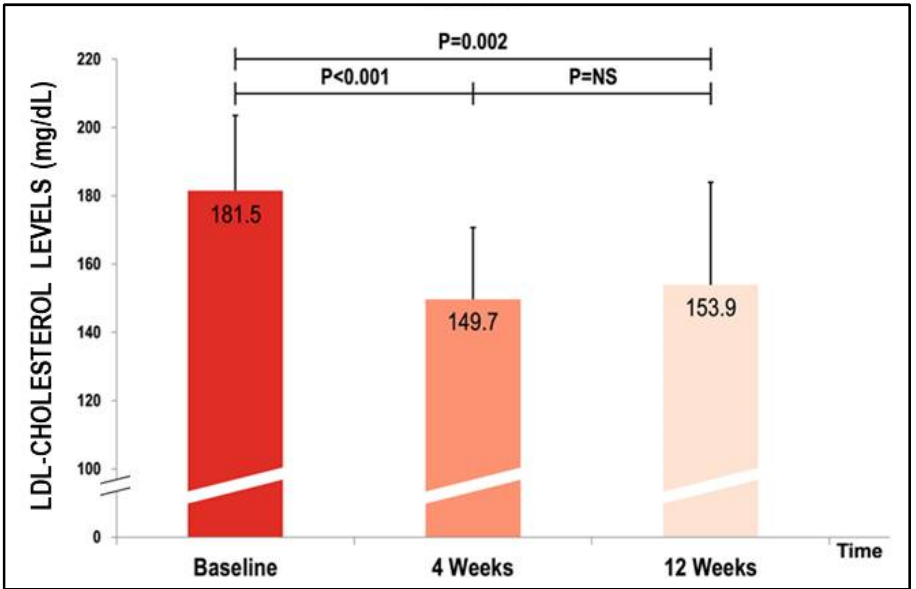
Figure 1. LDL-cholesterol levels at baseline and after four and 12 weeks of follow-up. Table 1. Biochemical evaluations at baseline and after four and 12 weeks of